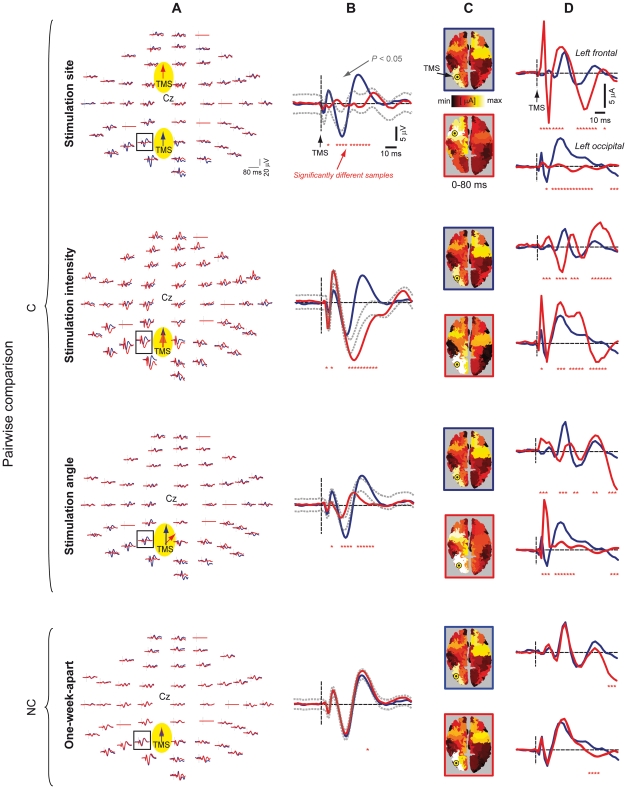
Results of pairwise comparisons between TMS-evoked potentials of a representative subject at the sensor (A,B) and at the source level (C,D).Brain responses to stimulation of BA19 at I% intensity and 0° angle on day1 (blue traces) are compared with brain responses recorded during four different sessions (red traces), during which stimulation parameters were varied one at a time, namely stimulation site (BA6), intensity (I%+10%), angle (45°) and day (day8), resulting in 3 C comparisons and one NC comparison. For each comparison, superimposition of pairs of TMS-evoked potentials in all sensors is displayed in (A), while enlarged view of P1 channel is shown in (B), together with significance boundaries (dotted gray traces) and significantly different samples (red stars). Pairs of TMS-evoked cortical currents are shown in (C) as current density maps and in (D) as temporal profile of current density integrated over the left frontal and left occipital lobules, together with significantly different samples (red stars).